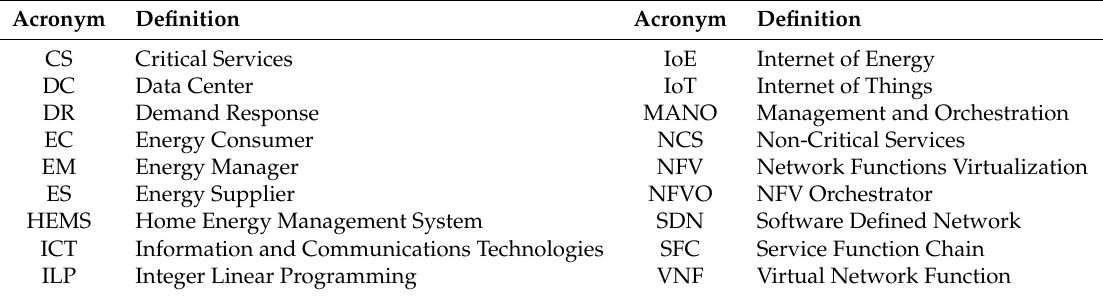
Table 1. List of acronyms and corresponding definitions.